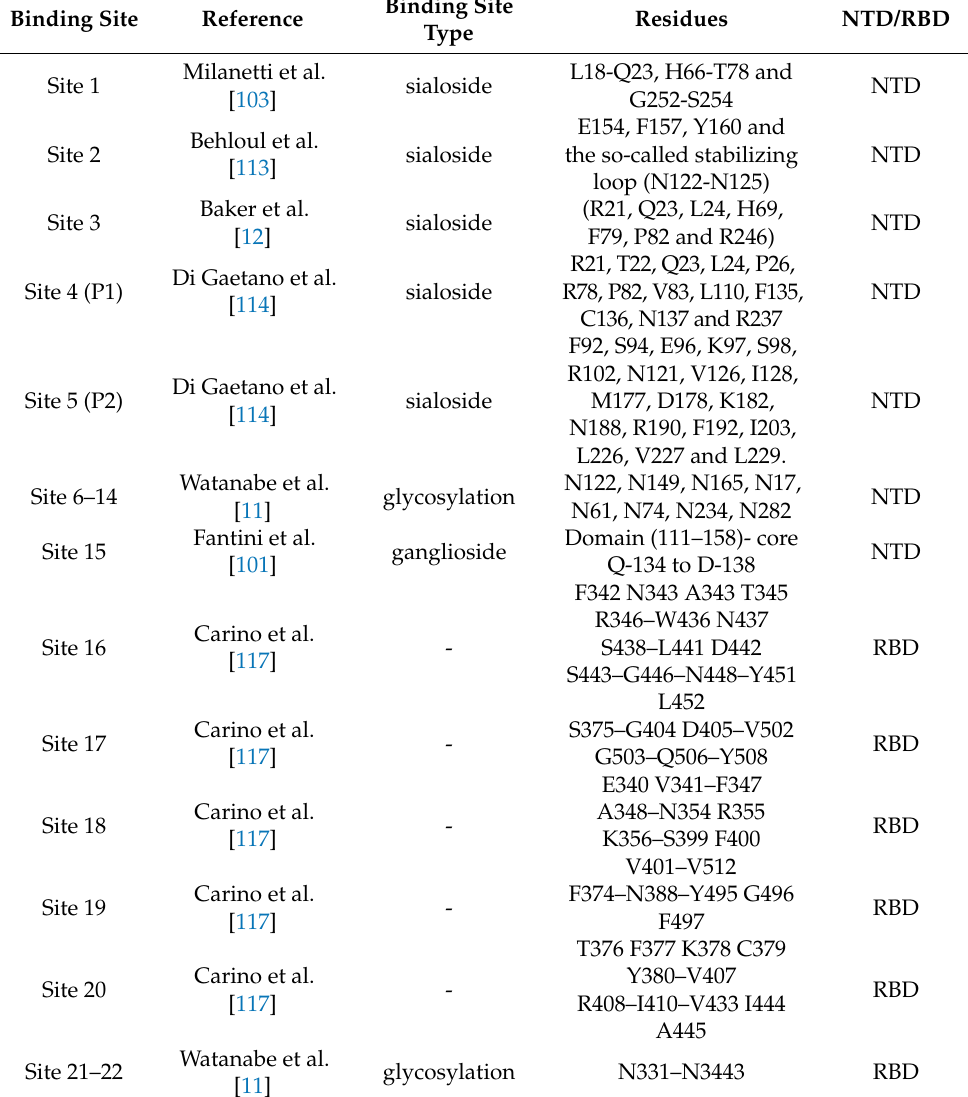
Table 1. Binding sites of spike NTD and RBD obtained from the literature (as reproduced from Table 3 in Aminpour et al. [3], with reference citation numbers adjusted to this reference